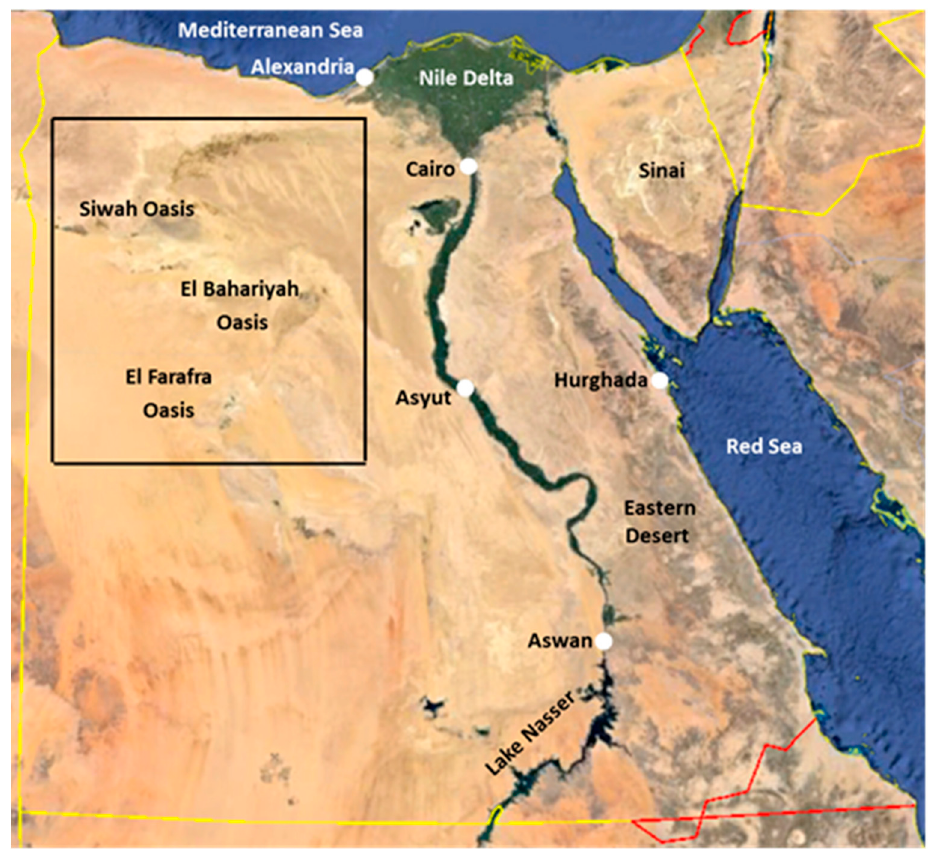
Figure 1. Map of Egypt showing the sites included in the analysis. The Western Desert region is marked by the rectangle (base map from Google Earth).